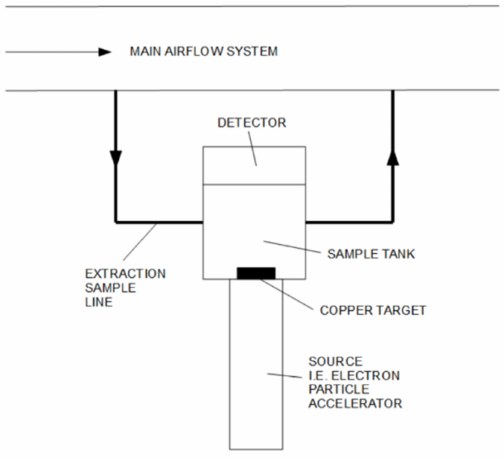
Figure 23. Detection—design and